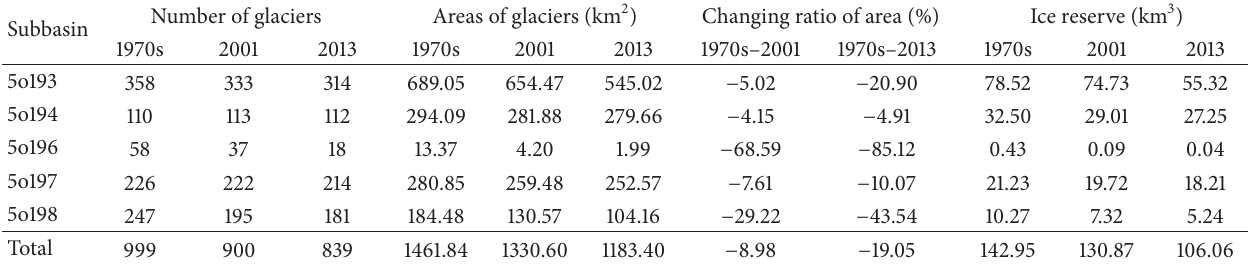
Table 1: Summary of glacier inventories in the Pumqu river basin for the 1970s, 2001, and 2013 periods. Number of glaciers Areas of glaciers (km 2 ) Subbasin